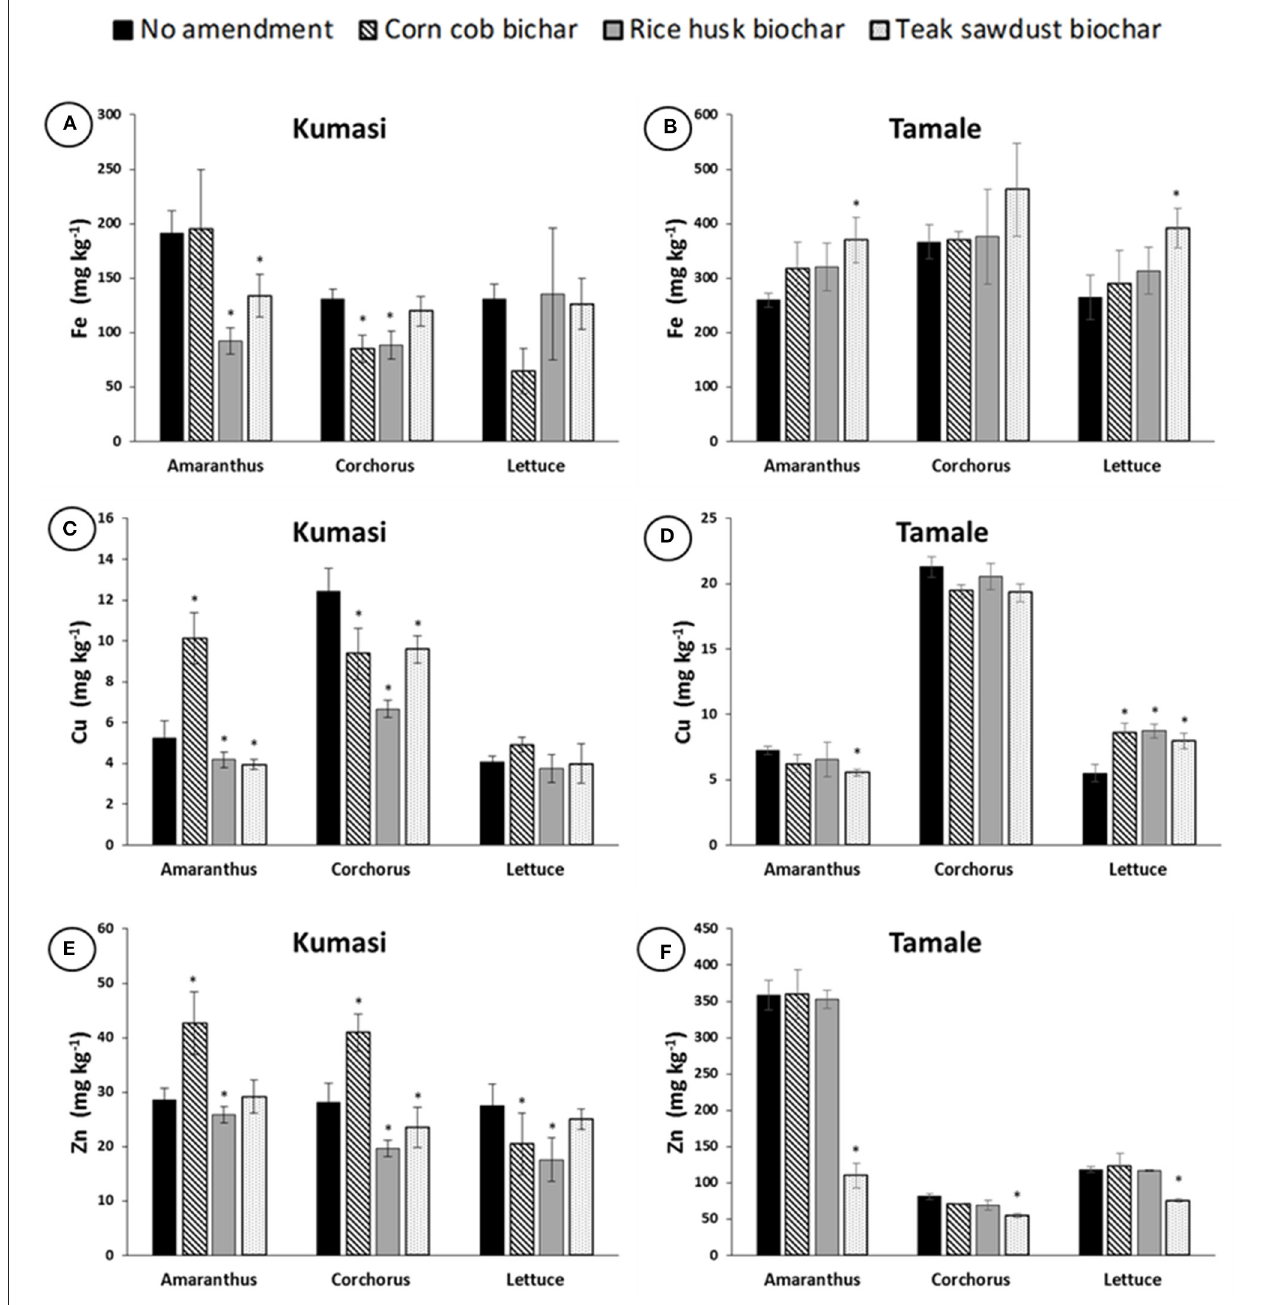
FIGURE 5 | Fe, Cu, and Zn concentrations in Amaranth, Corchorus and Lettuce grown in Kumasi (A,C,E) and Tamale (B,D,F) soils amended with 5% (w/w) corn cob biochar, rice husk biochar, or teak sawdust biochar. Data with asterisks are statistically significantly different from control for each crop ( p < 0.05). Error bars represent standard deviation n =